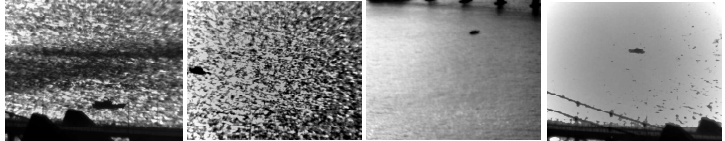
Figure 1. Typical infrared maritime backlight image.